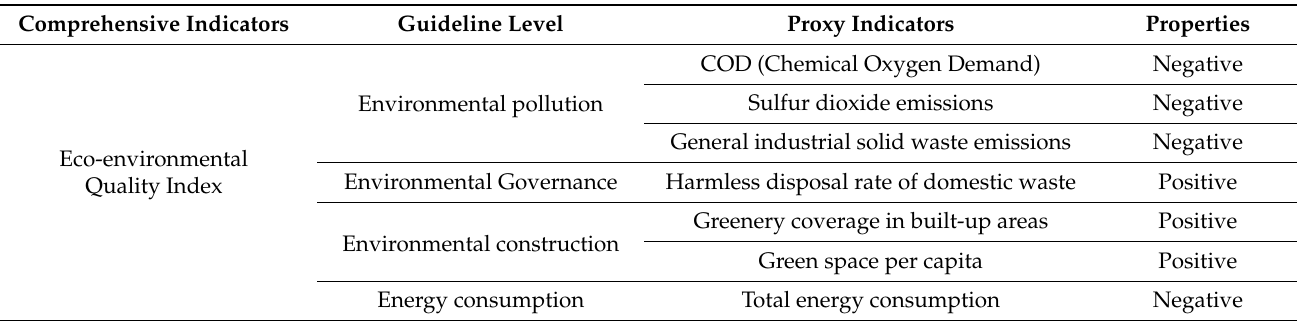
Table 3. Construction of a comprehensive evaluation system.